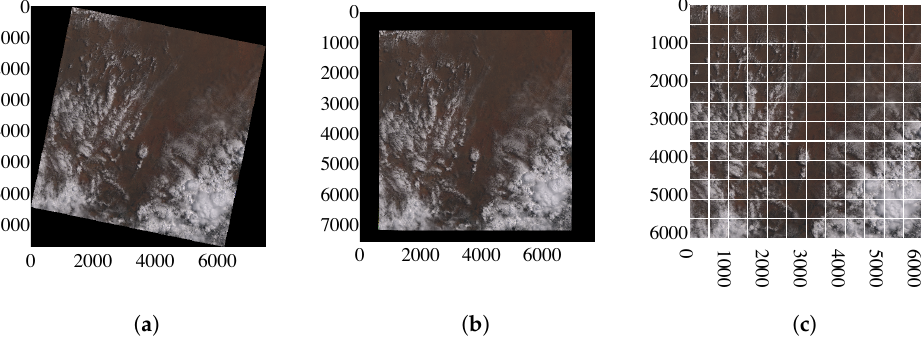
Figure 4. L8 Biome dataset scene during different preprocessing steps [35]. ( a ) Image patch. ( b ) Ro- tated patch. ( c ) Cropped patch with tiling.